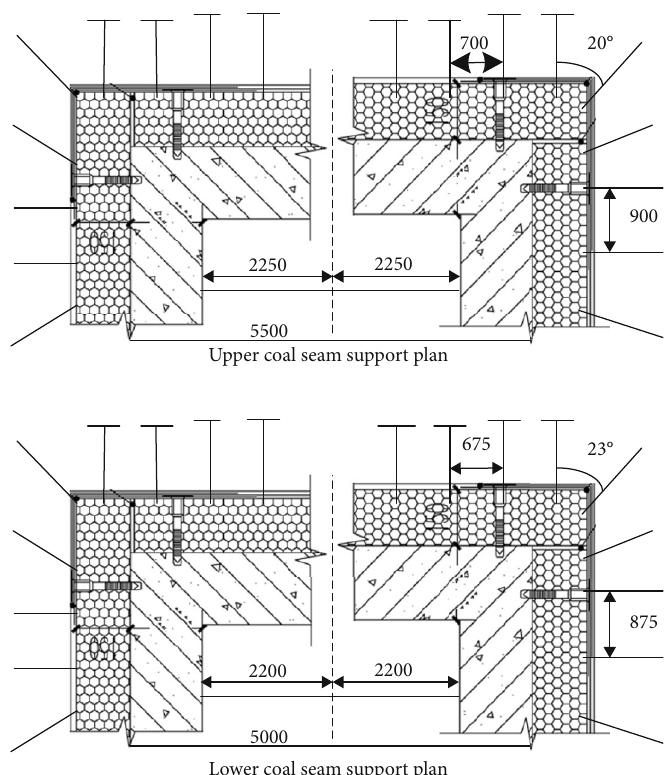
Figure 3: Original supporting plan of the face transportation